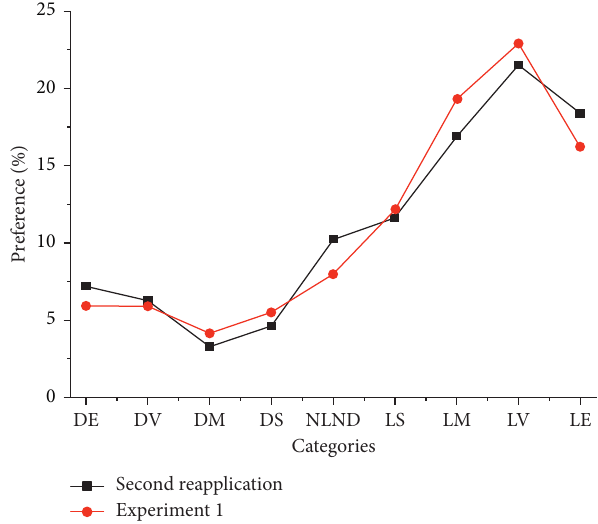
Figure 17: Comparison between the responses of Experiment 1 and the second